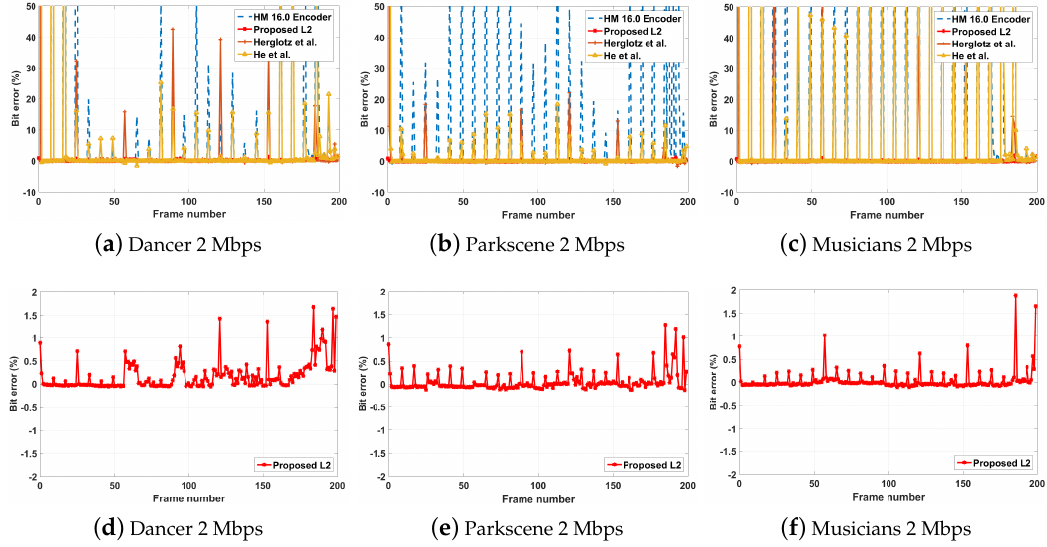
Figure 2. ( Top row ): An illustration of the frame-wise percentage error between the allocated bits and actual bits for the HM 16.0, proposed, and other state-of-the-art algorithms for three HD test sequences. ( Bottom row ): A further illustration of the percentage frame-wise rate control performance of the proposed